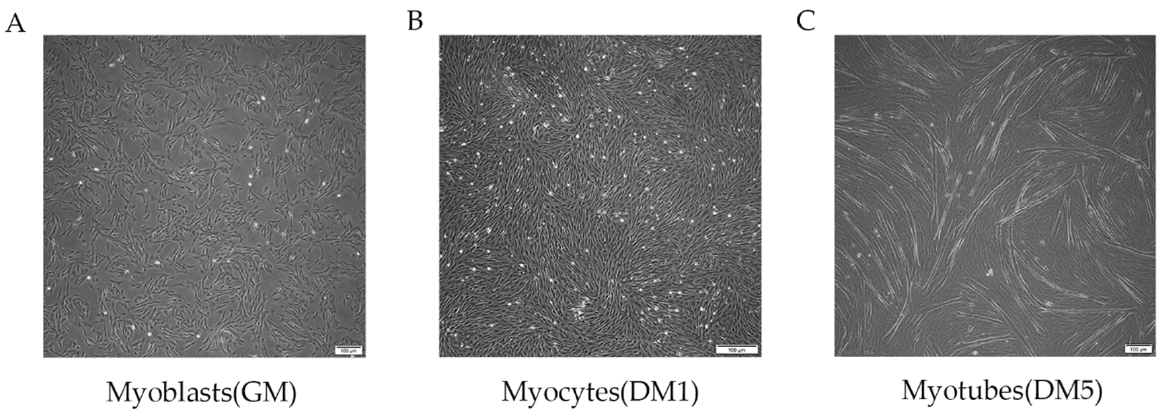
Figure 1. MuSC differentiation program; phase-contrast micrographs depicting cultures of goat MuSCs in proliferating conditions (growth medium (GM)) ( A ), in early myogenesis after 24 h in differentiation medium (Myocytes, DM1) ( B ), and in late myogenesis, including myotubes, after 5 days in DM (Myotubes, DM5) ( C ).